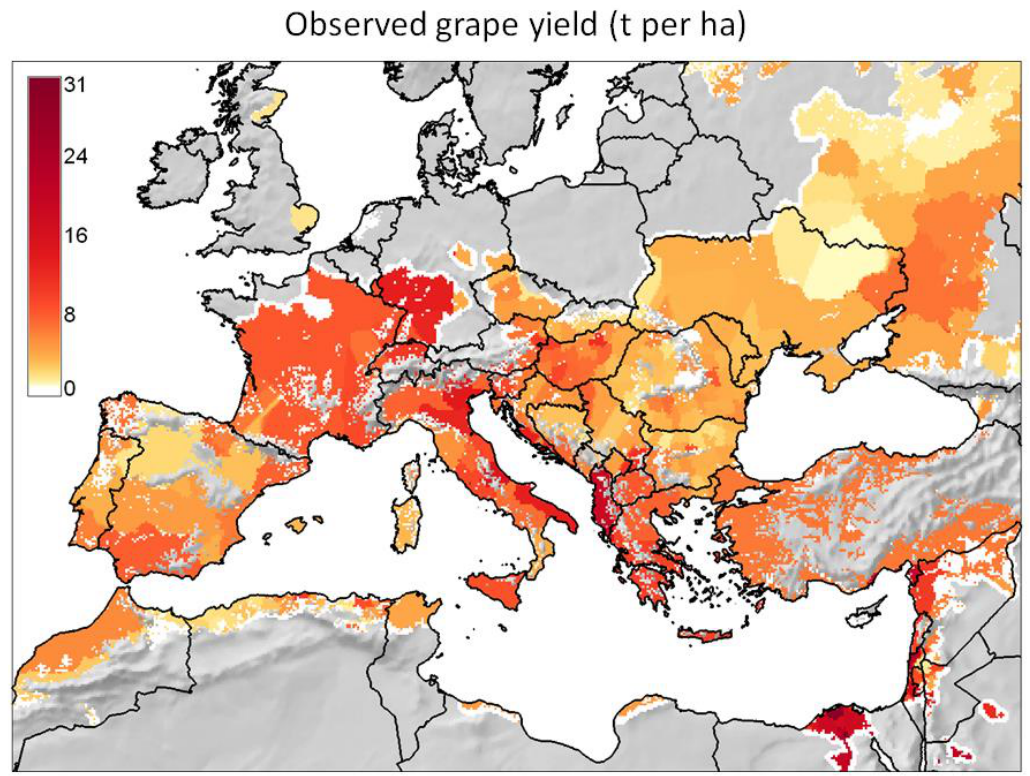
Figure 4. Observed grape yield ( t per ha) for the reference year 2000 (data from [62]) mapped for the observed geographic distribution shown in Figure 3. Note that missing data for Sicily in [62] were filled using AGRO-MAPS data [65].